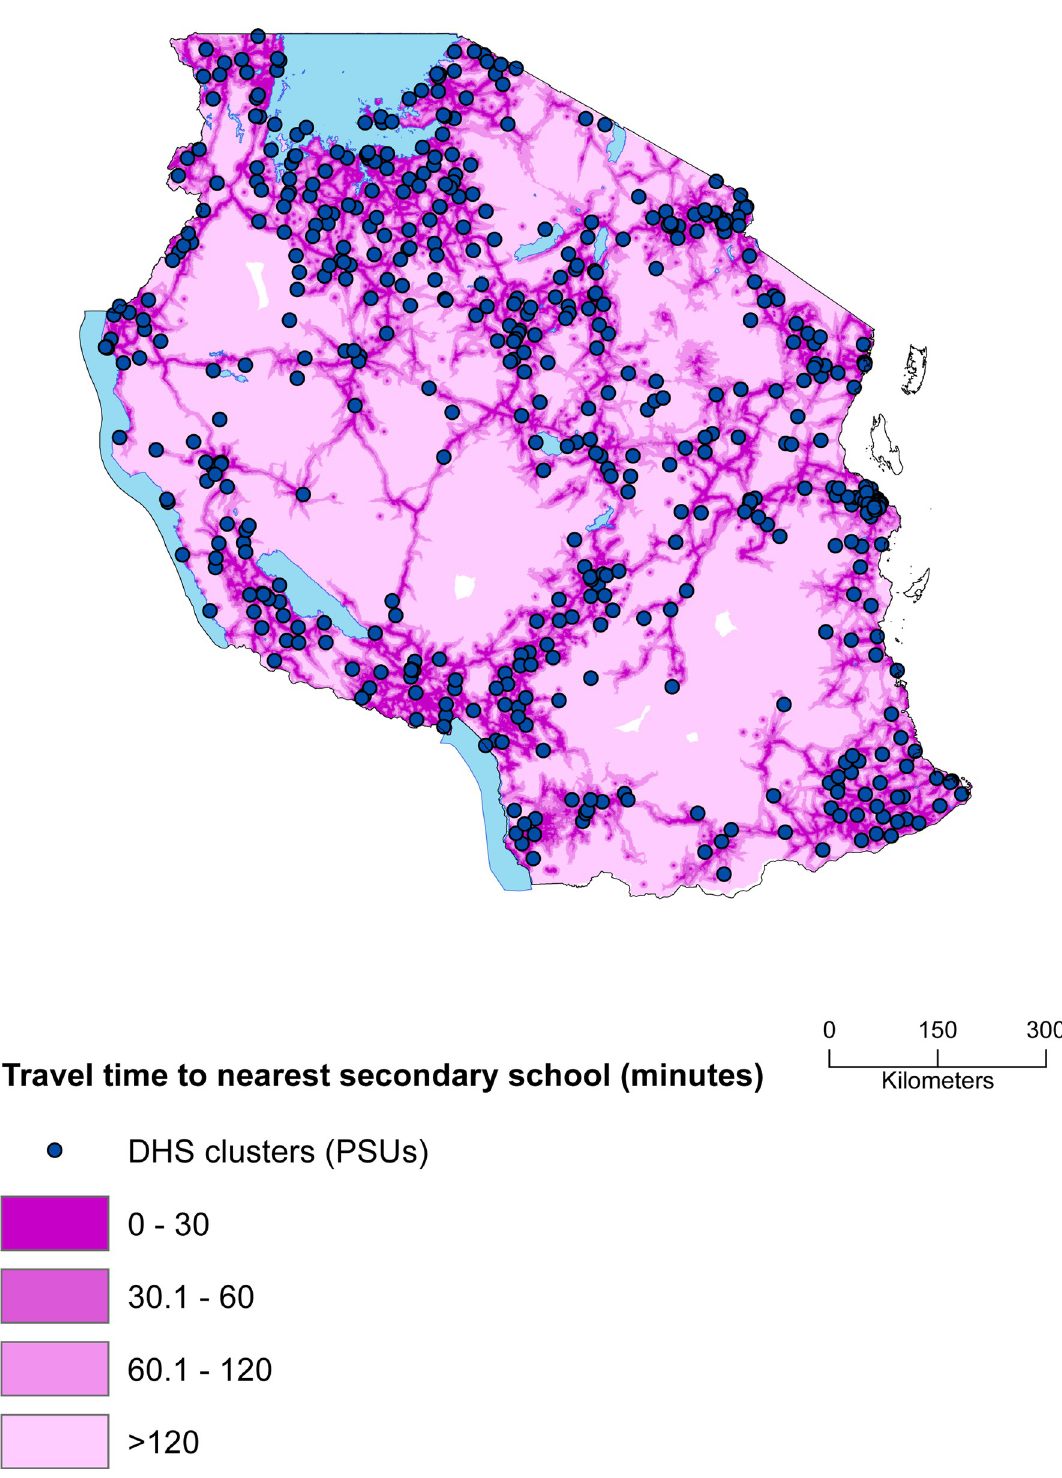
Fig 2. Geographic variation in theoretical travel time to the nearest secondary school. The blue dots are locations of DHS clusters (n = 595); Light blue areas are large water bodies extracted from the open source repository DivaGis (www.diva-gis.org). DHS clusters, also called primary sampling units (PSUs) are typically census enumeration areas (EAs) which form the survey cluster.